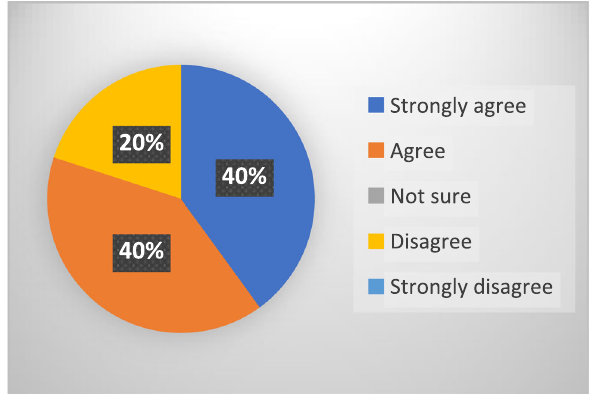
Fig. 2 Lack of communication between the practitioners of disaster risk reduction and climate change adaptation activities